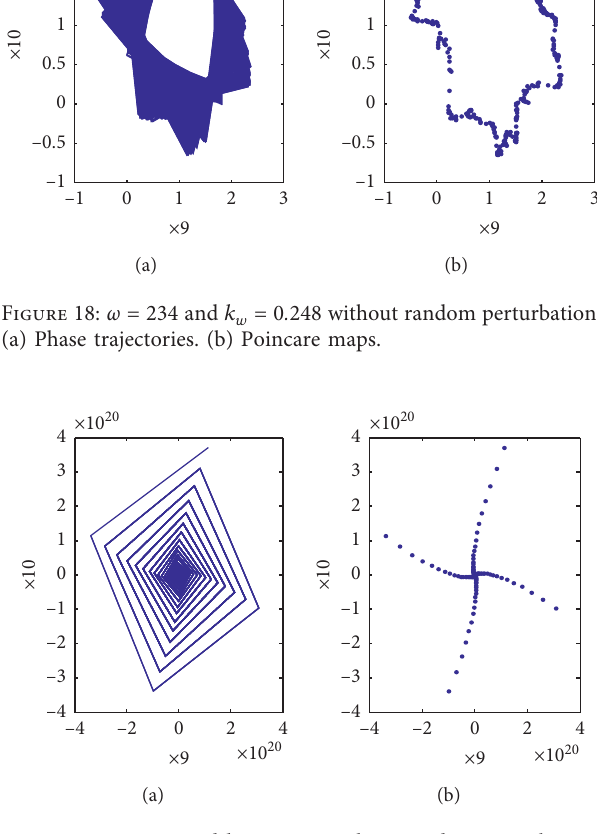
Figure 19: ω � 240 and k � 0 . 248 without random perturbation. w (a) Phase trajectories. (b) Poincare